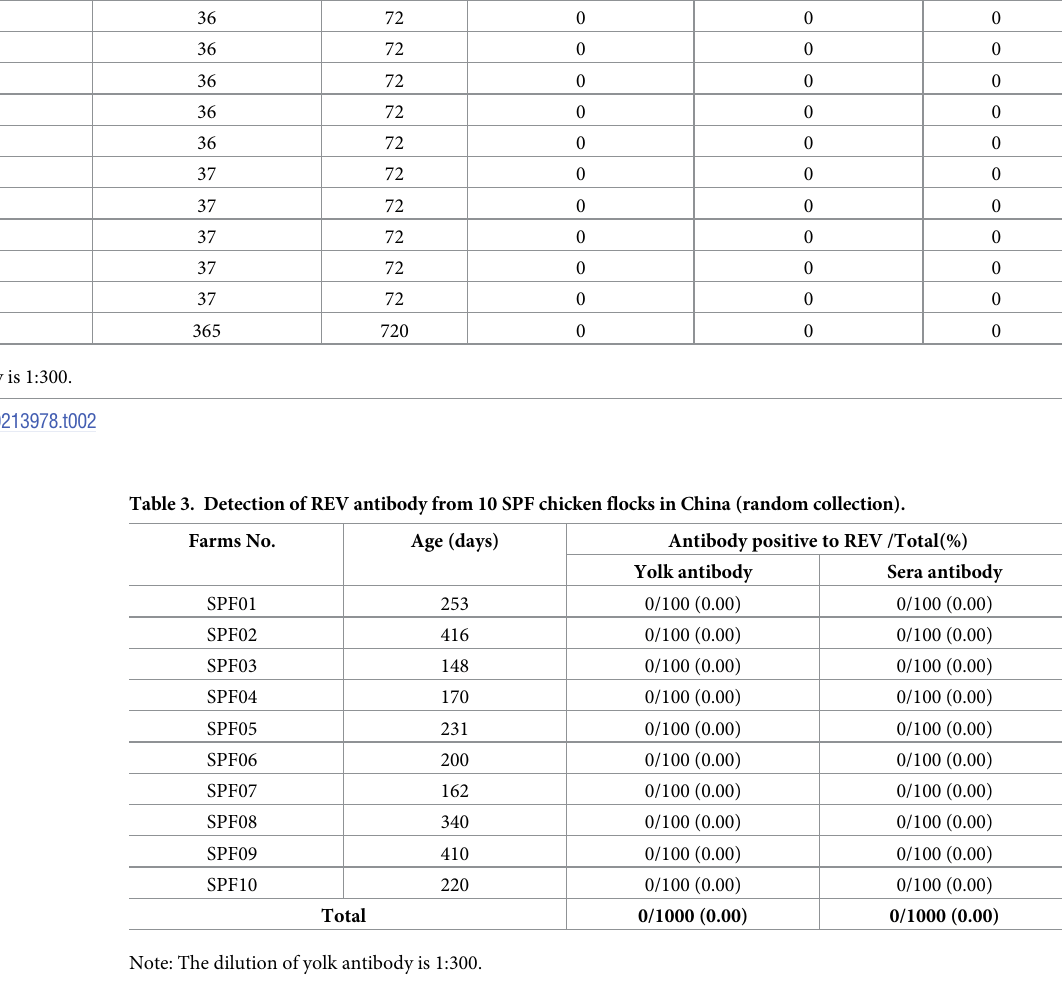
Table 2. Agreement of yolk and serum antibody measurements with different dilutions of yolk. Weeks yolk antibody consistent well with serum antibody yolk antibody is on the contrary to serum antibody Yolk (positive) Sera (positive)